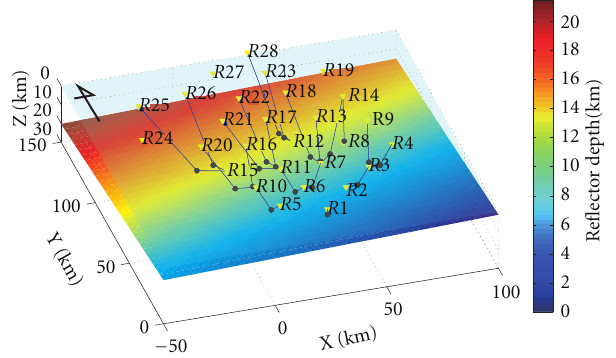
Figure 12: Reflection points estimated by a raypath calculation (black